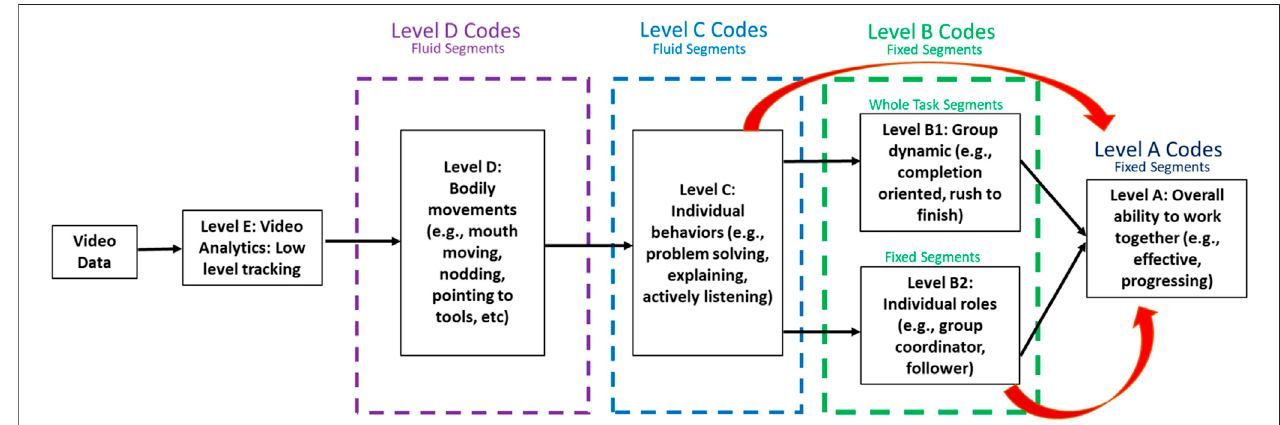
FIGURE 1 | The collaboration conceptual model. This illustration was fi rst described in (Som et al., 2020).